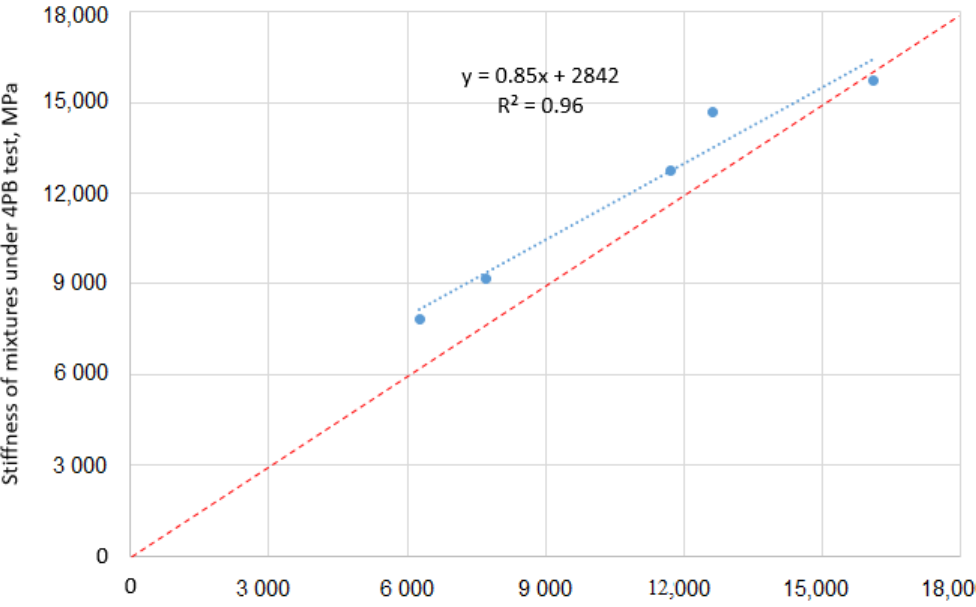
Figure 6. Comparison of the stiffness of trial batch mixtures obtained from laboratory tests and those calculated using the empirical